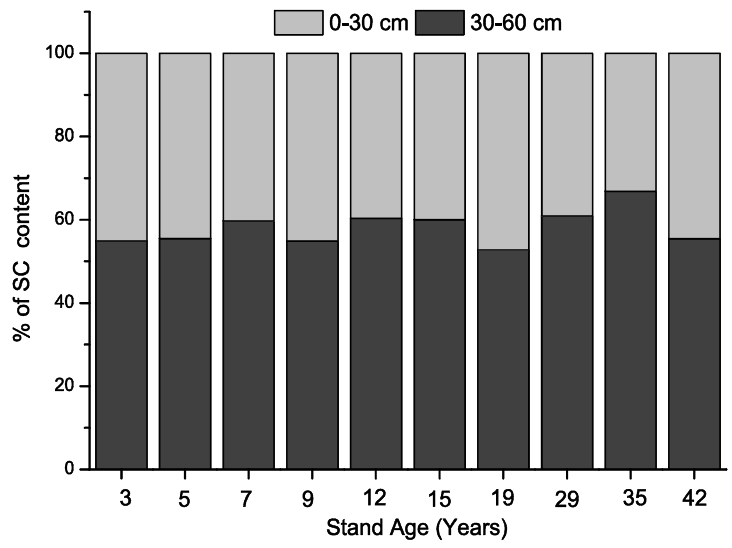
Figure 3. Percentage of mineral soil carbon content in the different soil layers of the different stand ages.